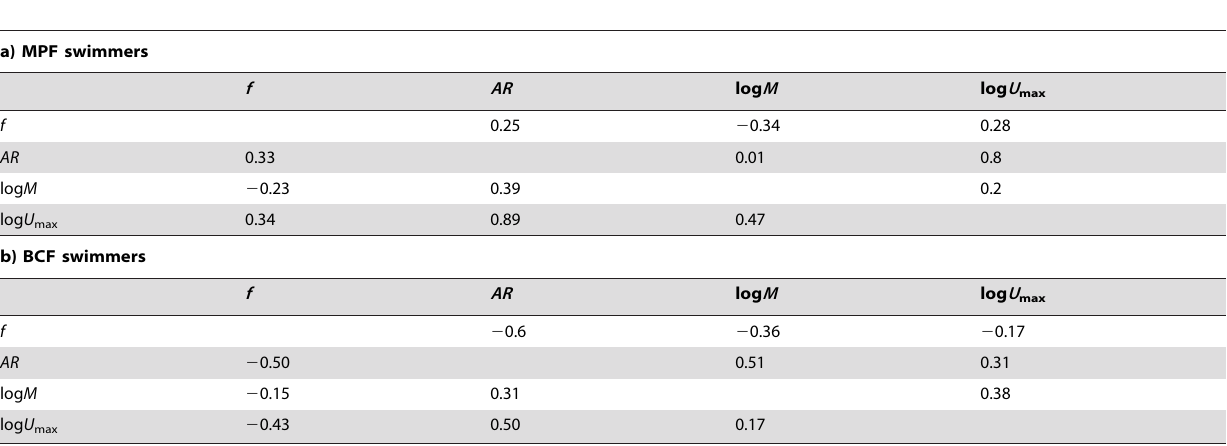
Table 2. Correlations among predictor variables and between predictor variables and maximum prolonged swimming speed, U max